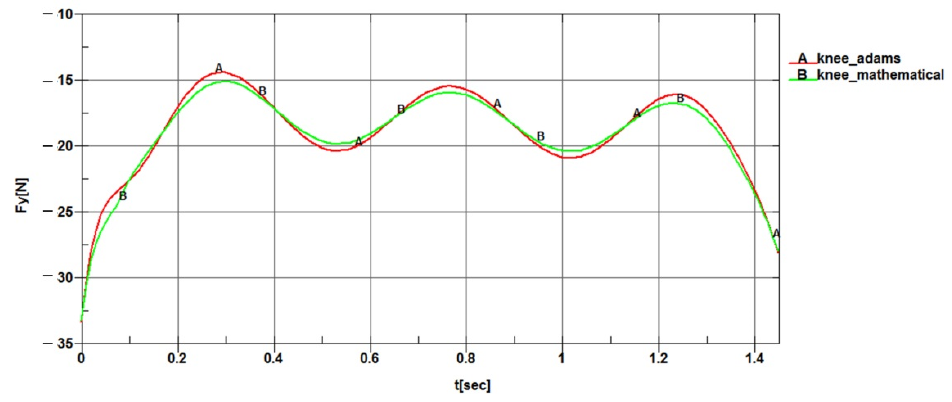
Figure 12. Connection forces component on y-axis for knee joint vs. time (without ground contact).